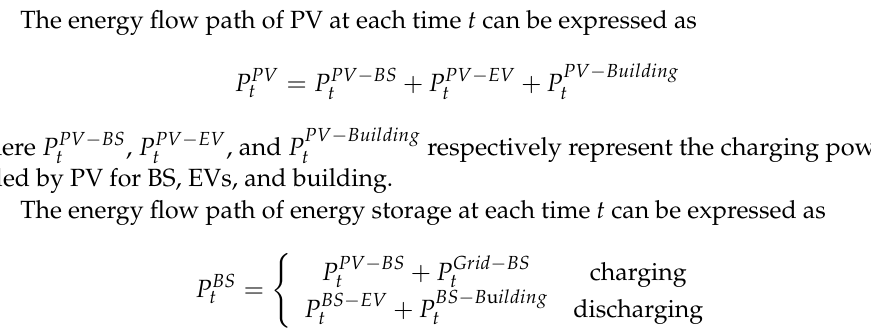
Figure 2. Energy path between different components in parking lot.